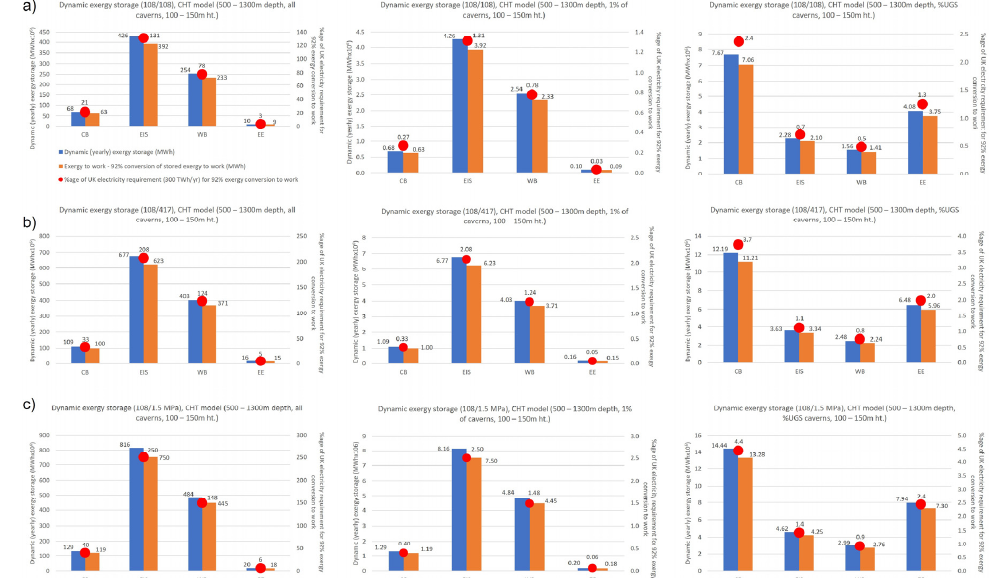
7 Figure 7. Plots of dynamic exergy storage and exergy to work estimates for the preferred CHT model, over the depth range 500–1300 m and cavern heights 100–150 m considered for CAES. Parts ( a – c ) show graphs for differing injection/withdrawal rates (108/108 kg/s and 108/417 kg/s) or fill and pressure reduction rates (108 kg/s/1.5 MPa/h) for all potentially available caverns, 1% of available caverns and estimates based upon the number of UGS caverns in the basins. Additionally shown, by basin, the percentage of UK electricity demand for 92% of stored exergy to work. Key common to all; see Figure